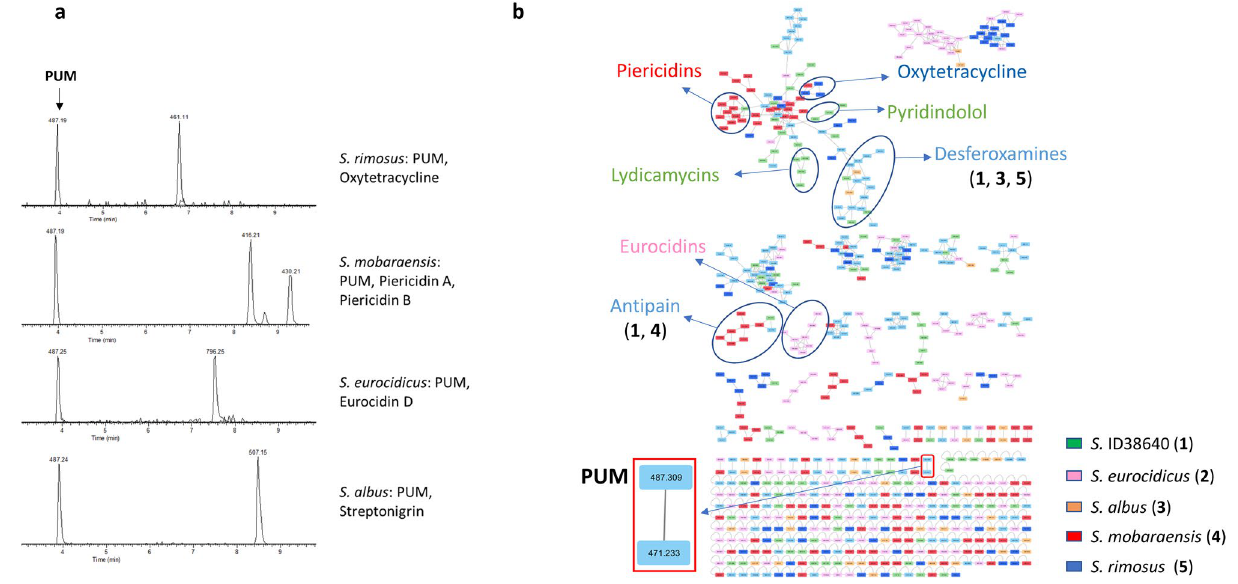
Figure 4. Analysis of PUM production in other Streptomyces strains. ( a ) Extracted ion chromatograms of PUM ( m/z 487 [M + H] + ) and strain specific metabolites from S. rimosus, S. mobaraensis, S. eurocidicus and S. albus . ( b ) Complete molecular network of two samples from each of the above PUM producers and from ID38640. Strain-specific features are color coded as: ID38640, green; S. eurocidicus , pink; S. albus , orange; S. mobaraensis , red; and S. rimosus , blue. Features detected in more than one strain are in light blue. All strains were cultivated in M8 medium and samples prepared at 72